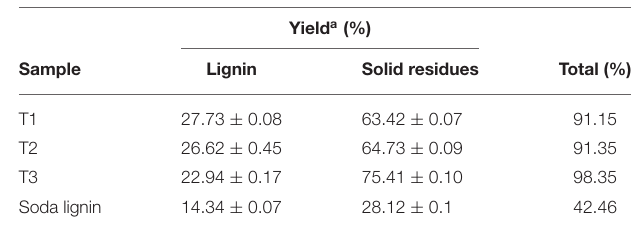
TABLE 7 | The total mass balance of extracted lignin samples and alkali treated solid residues in the separation and recovery process.